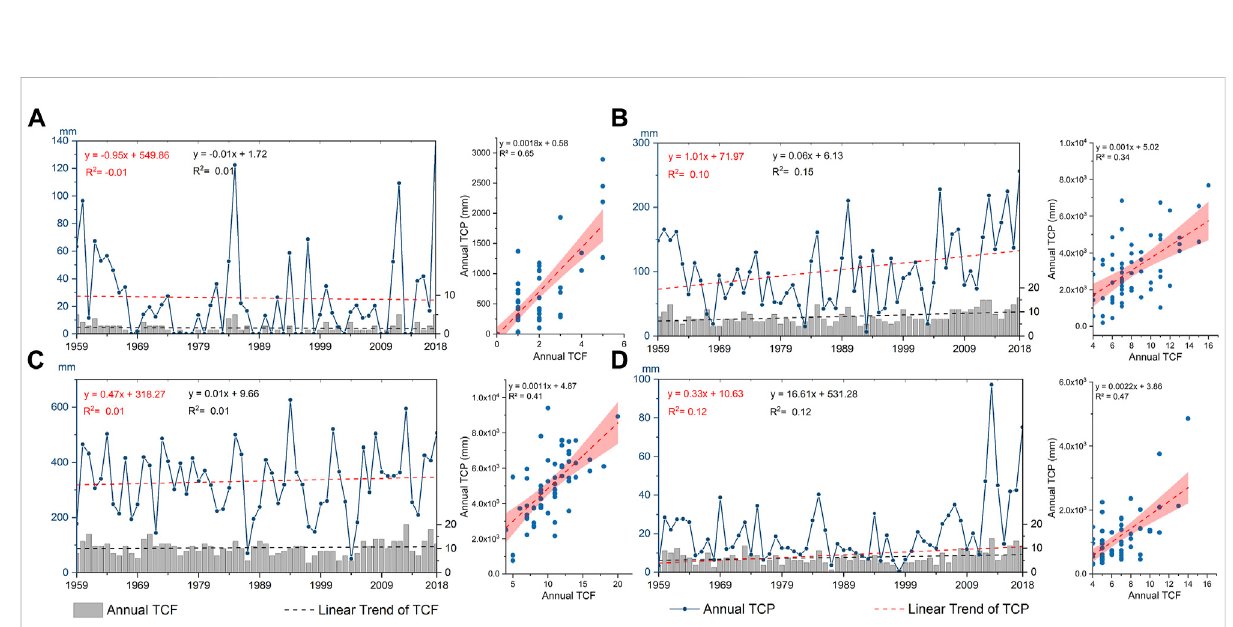
FIGURE 3 Annual total TCP and TCF in subregions from 1959 to 2018 (A) northeastern China, (B) eastern China, (C) southern China, and (D) inland